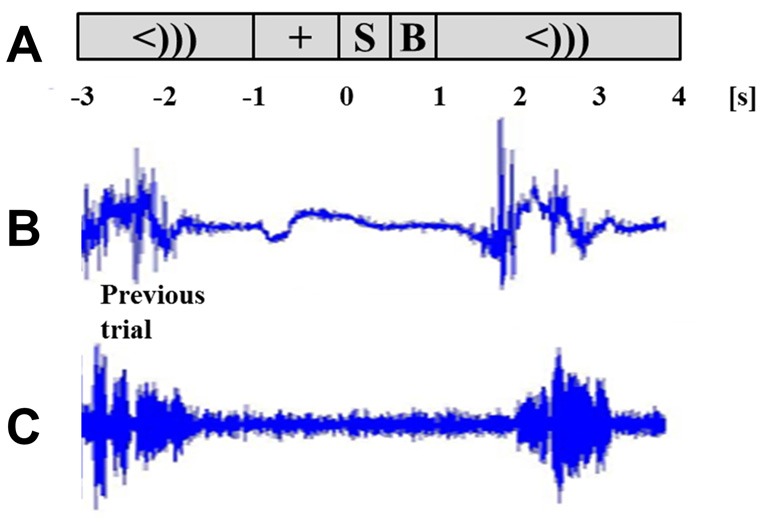
Task schematic and time course of two successive trials. Task sequence (A) includes a fixation (+) of alternating length (1 or 2 s), stimulus sentence (S, 0.5 s), a blank screen (B, 0.5 s) and the cue to speak (<))), 3 s). Lip EMG signal (B) and voice signal (C) are taken from one participant. The response of the previous trial and the succeeding trial are shown for the chosen participant.